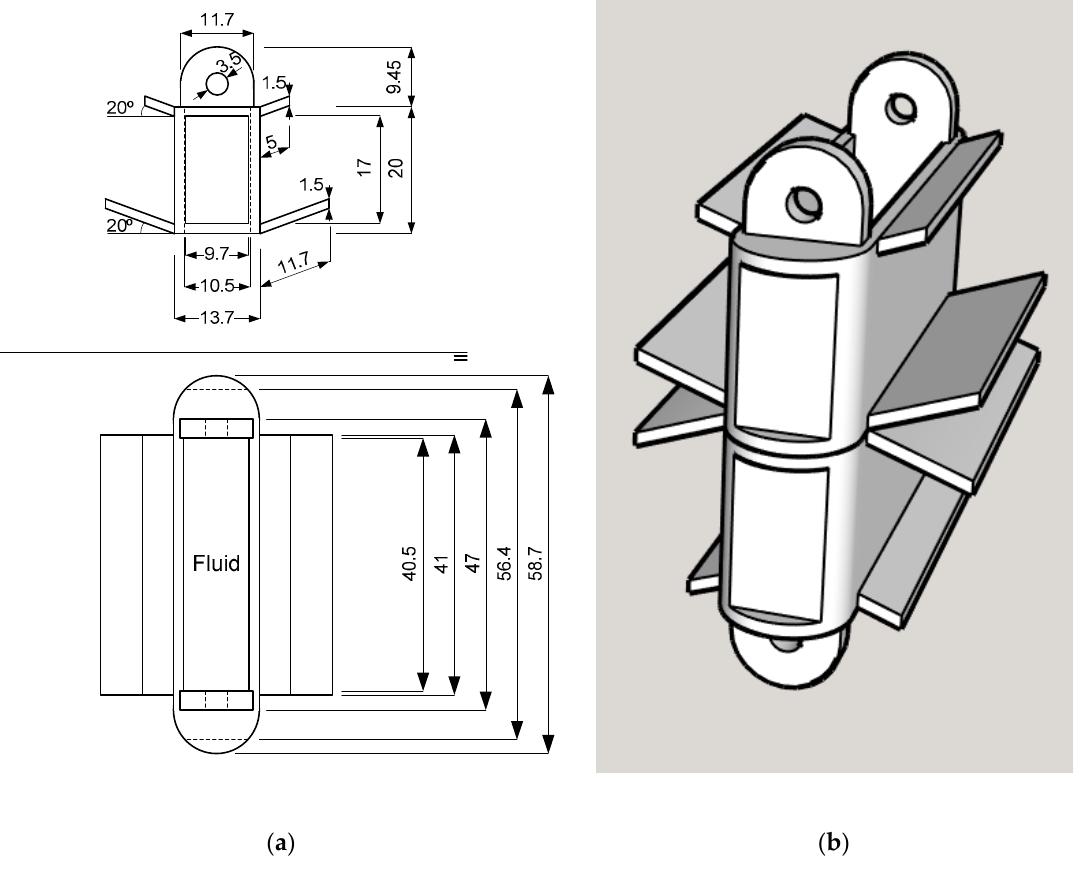
Figure 4. Dual coil holders’ design ( a ) Fluid core dual coil holder dimensions. ( b ) Dual coil holders’ disposition. They were aligned vertically for the free fluid circulation between them.